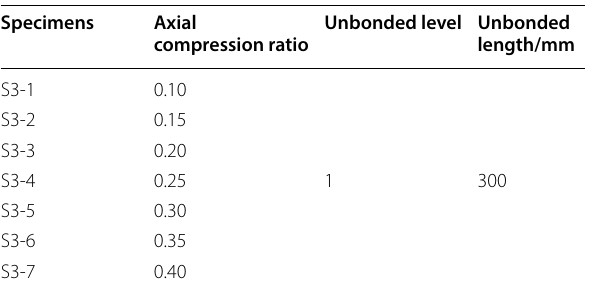
Table 11 Simulated variable parameters of axial compression ratio. Specimens